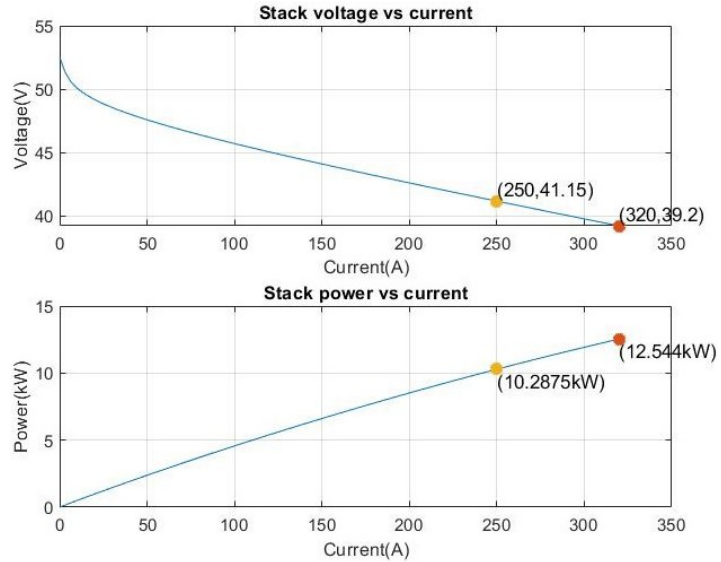
Figure 6. Fuel cell stack performance curve